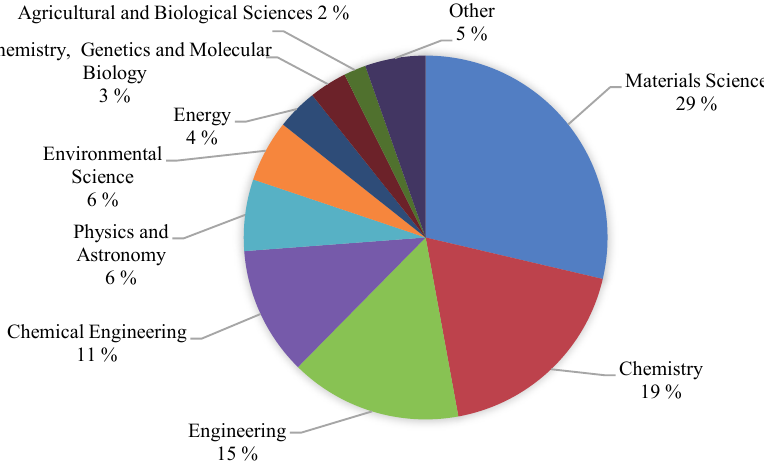
Fig. 3. Journal articles on topic of biobased epoxy by research